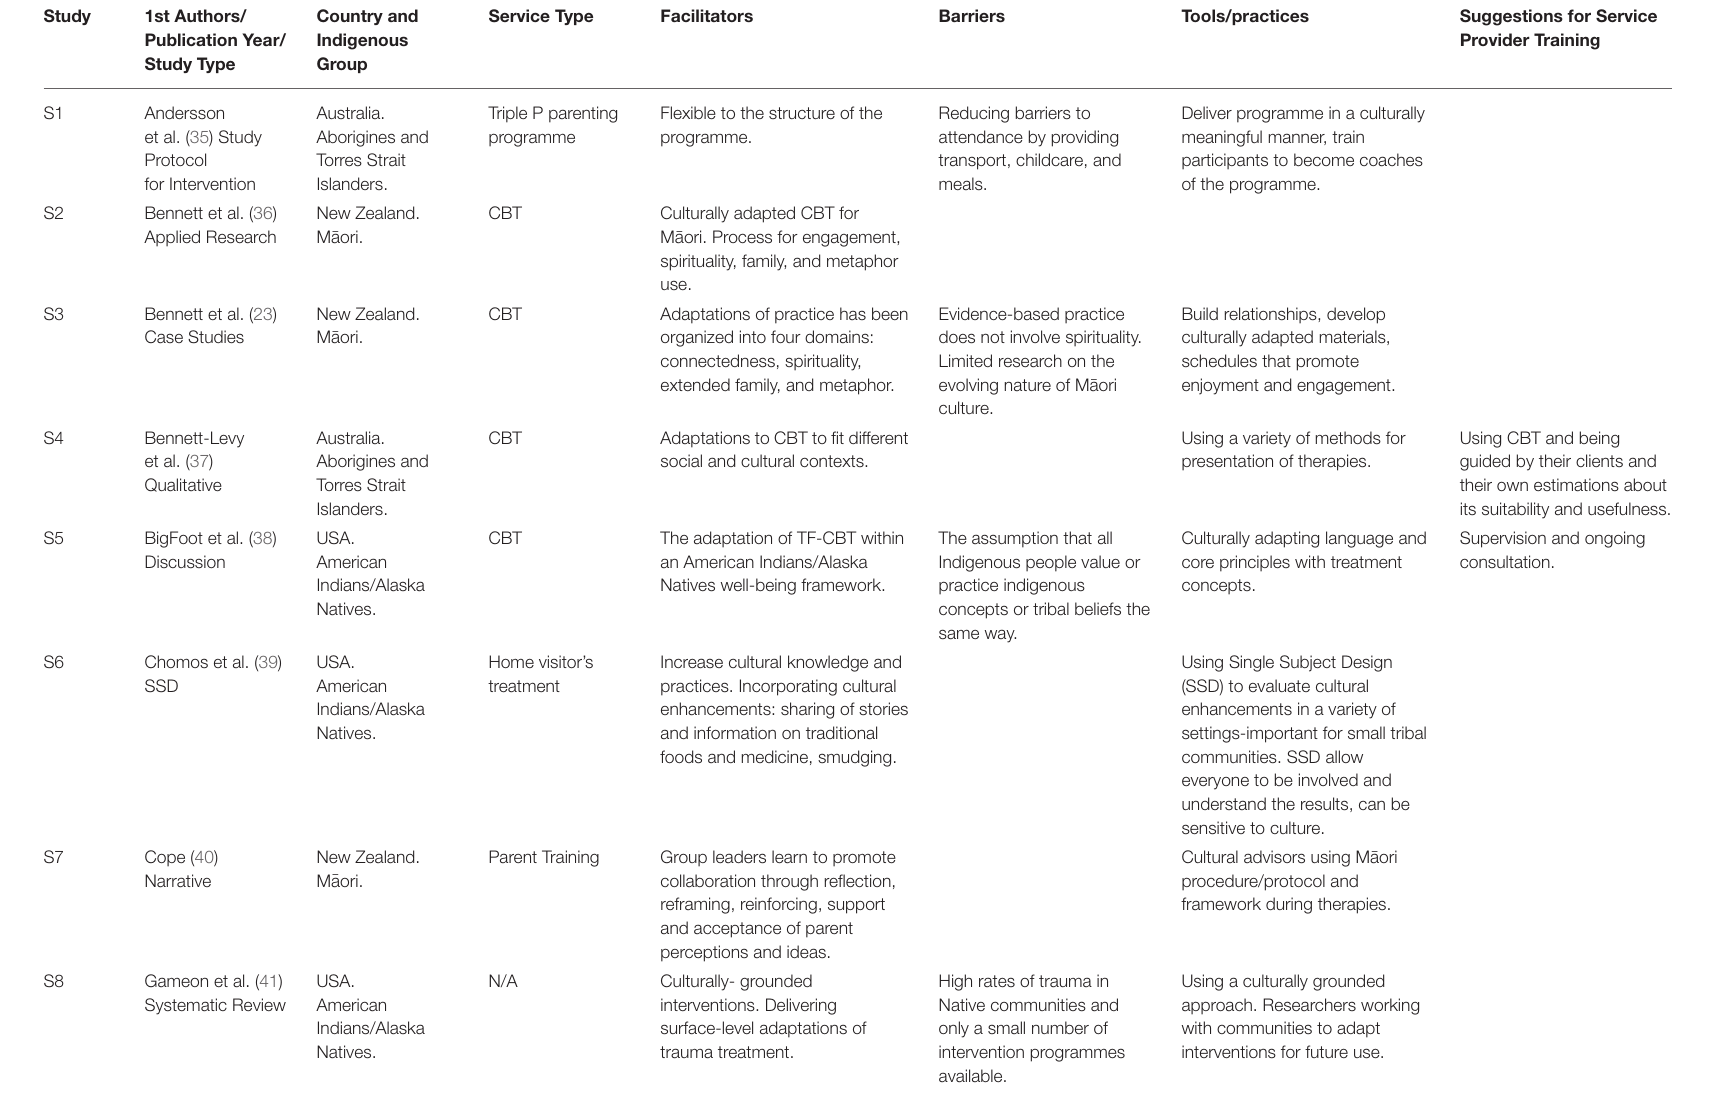
TABLE 2 | Summary of extracted data by source for this review.